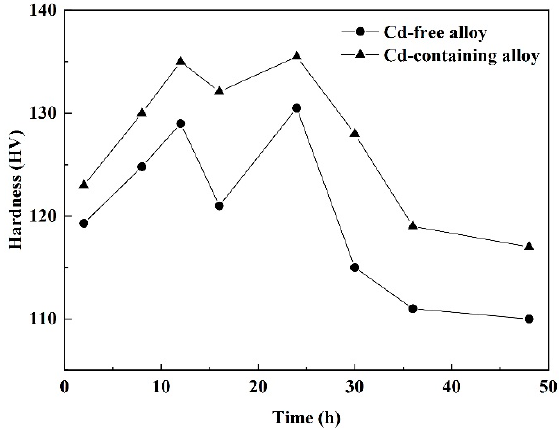
Figure 3. Hardness evolution of the alloys during aging at 175 °C.